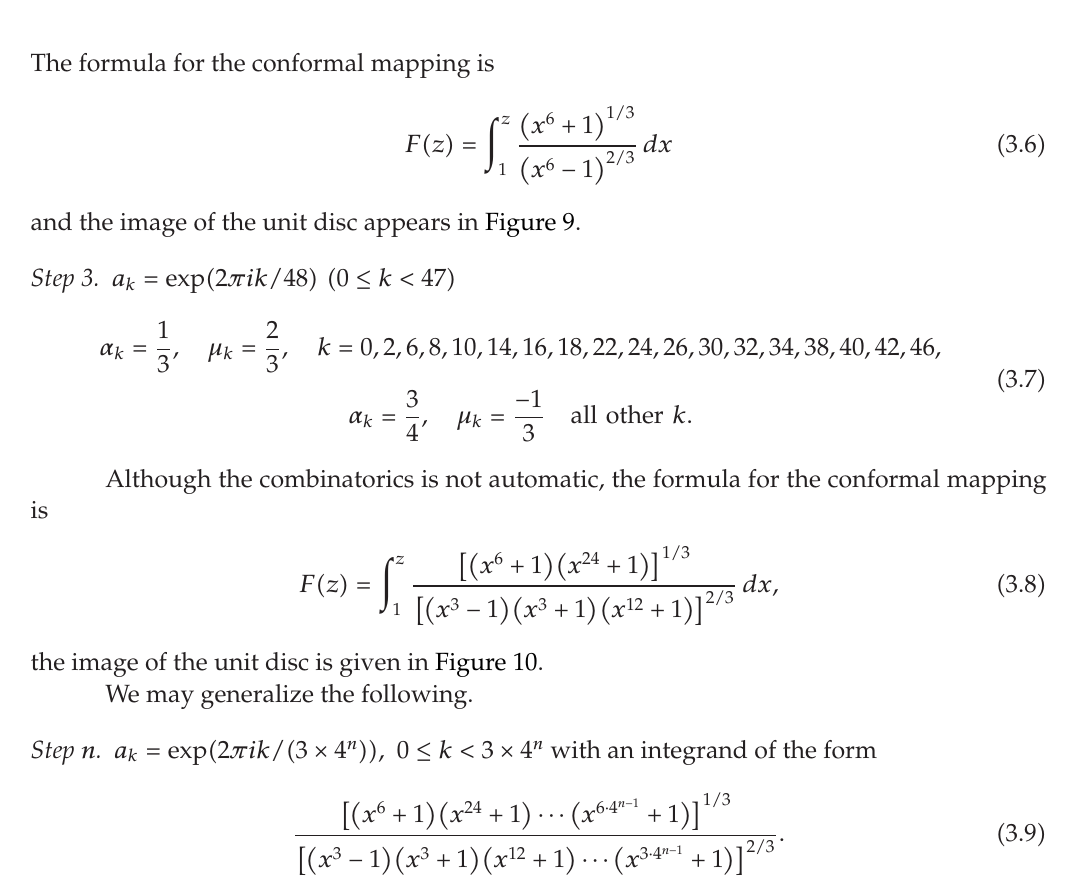
Figure 9: Interior the Koch snowflake, Step